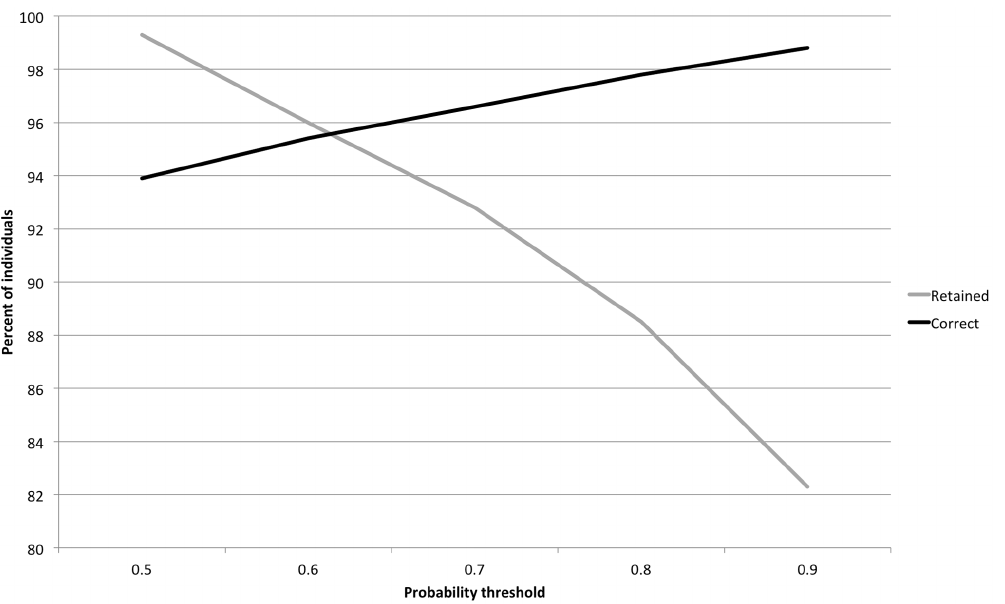
Figure 3. At higher levels of confidence in individual assignment (high posterior probability of group membership), more simulated individuals were correctly classified, but fewer of them met the threshold for inclusion in the analysis, and sample size for trait estimation declined.